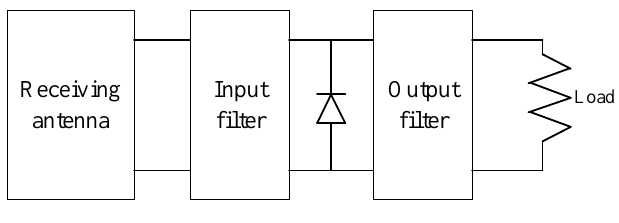
Figure 5. Rectifying antenna